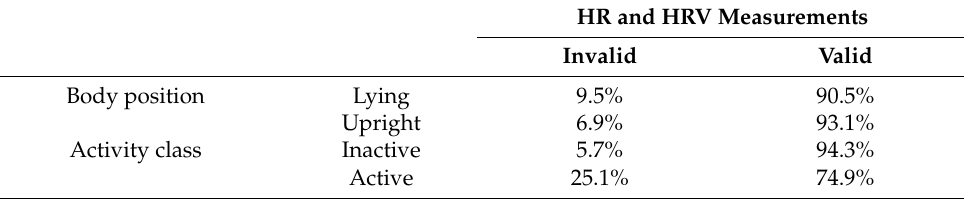
Table 1. Proportions of invalid vs. valid epochs of HR and HRV measurements depending on body position and activity